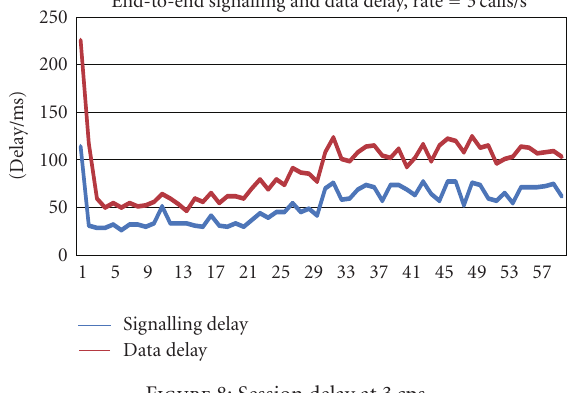
Figure 8: Session delay at 3cps.